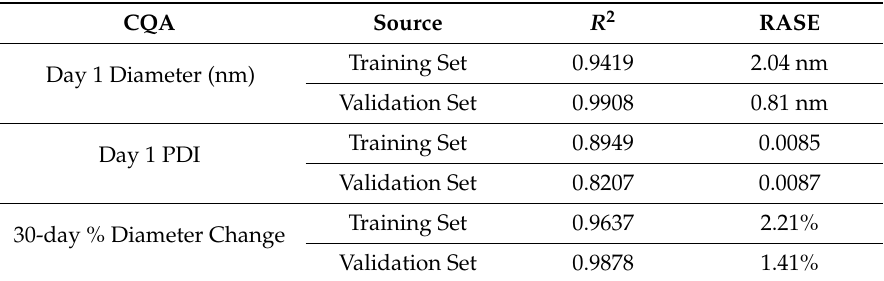
Table 8. R 2 and RASE for the MLR models developed from the augmented design of experiments. Training and validation sets consisted of 75% and 25% of the data, respectively. Validation sets were selected using a stratified random sampling of the output of